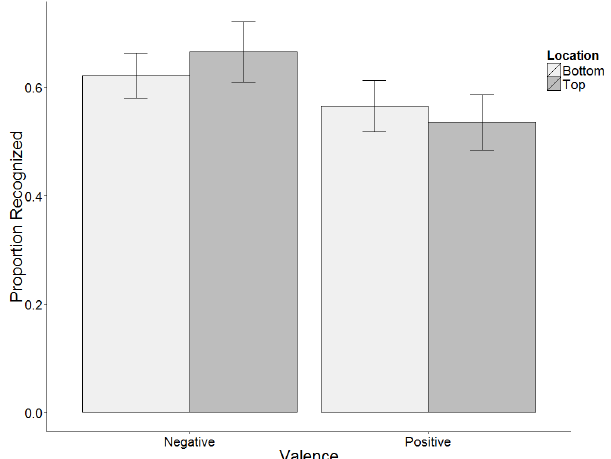
Figure 2. Mean proportion of words recognized by valence and location. Experiment